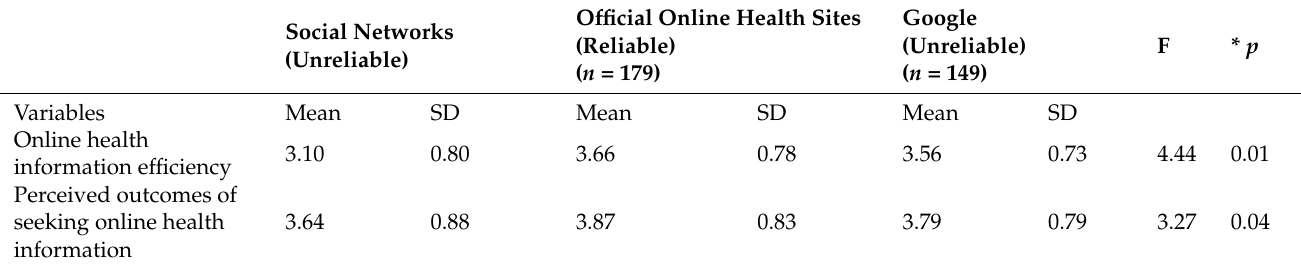
Table 3. Types of online sources used by the elderly, their perception of online health information efficiency and the outcomes of seeking online health information.